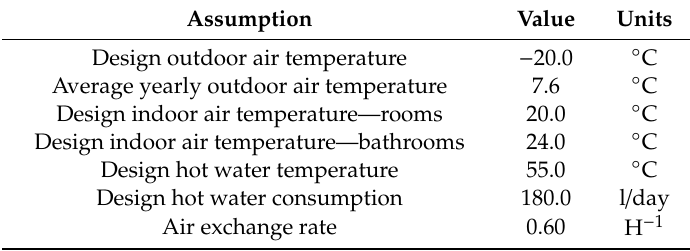
Table 5. Assumptions used for the energy need and design heating load calculation for the WT2021, NF40 and NF15 standards.